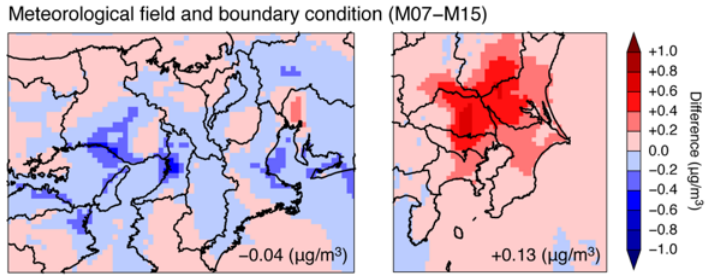
Figure 8. Spatial distributions of the difference caused by the boundary condition and the meteorological field between M07 and M15 over (left) domain 3 and (right) domain 4. The value shown in the lower-right side indicates the spatially averaged differences.